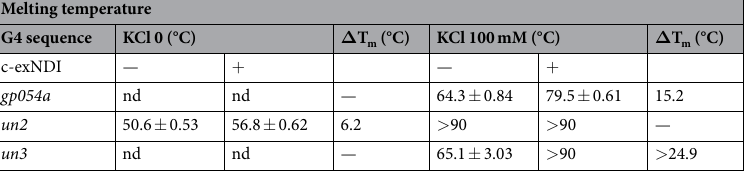
Table 1. Melting temperatures (T m , °C) of HSV-1 G4 folding sequences measured by CD in the absence or presence (100 mM) of KCl. Each sequence (4 μ M) was analyzed in the absence or presence of c-exNDI (16 μ M). nd stands for “not